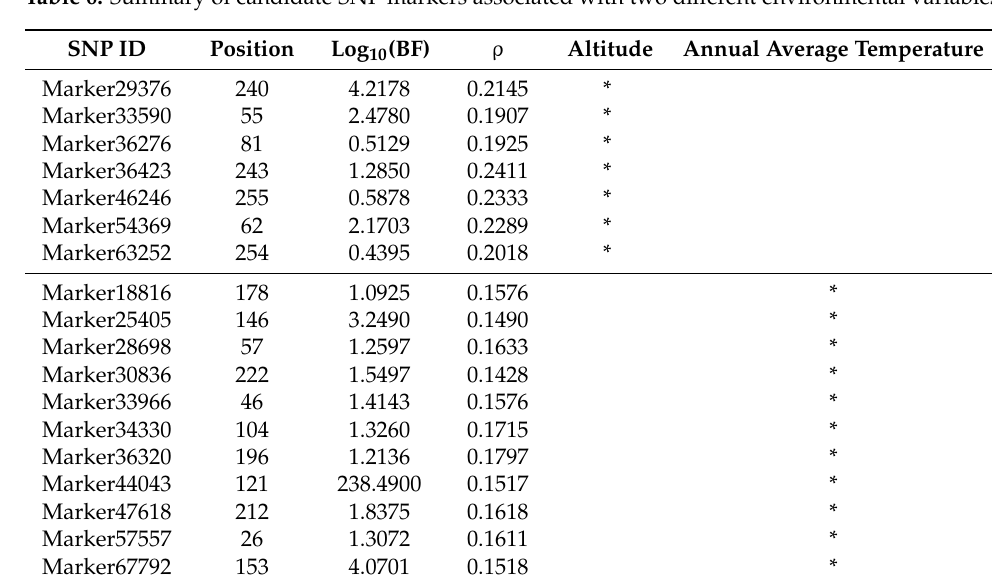
Figure 3. Phylogenetic tree of Chosenia arbutifolia . ( a ) The dendrogram was constructed at the level of individuals and ( b ) based on populations. Table 6. Summary of candidate SNP markers associated with two different environmental variables.